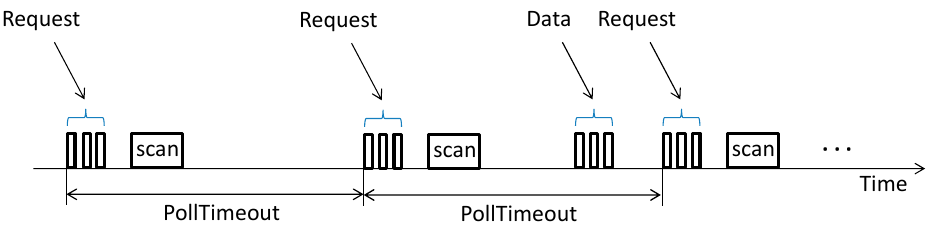
Figure 4. Polling and data message transmission operations carried out by a BM-LPN. In this example, data message transmission is only performed in the second PollTimeout interval.